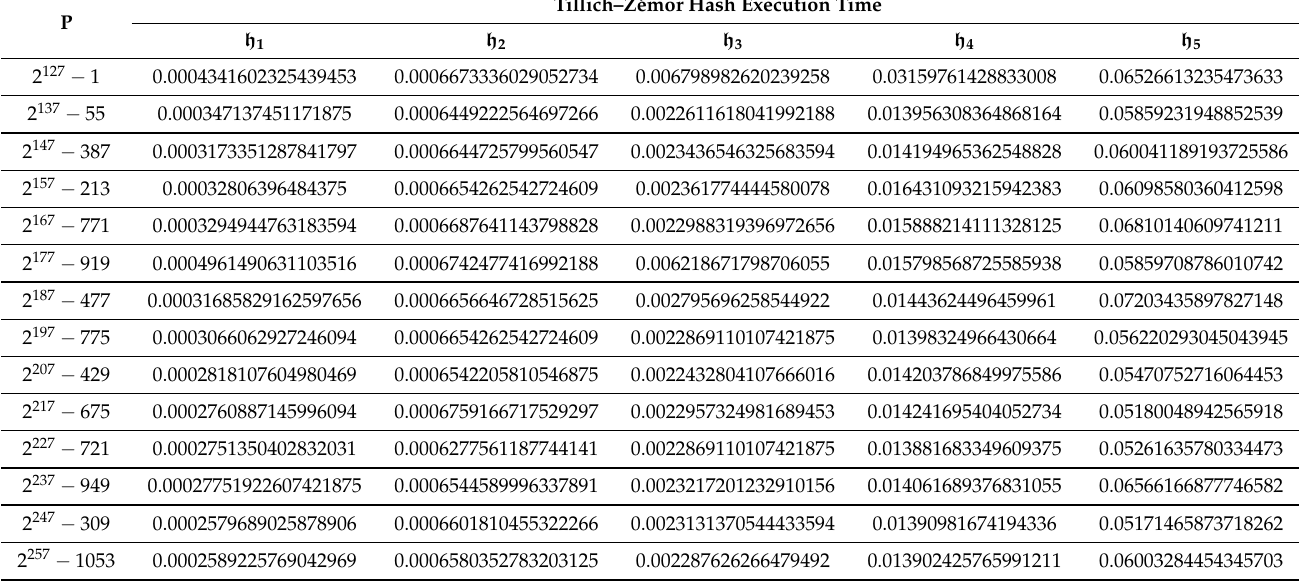
Table 4. Execution time to compute Tillich–Zémor hash values of Brauer